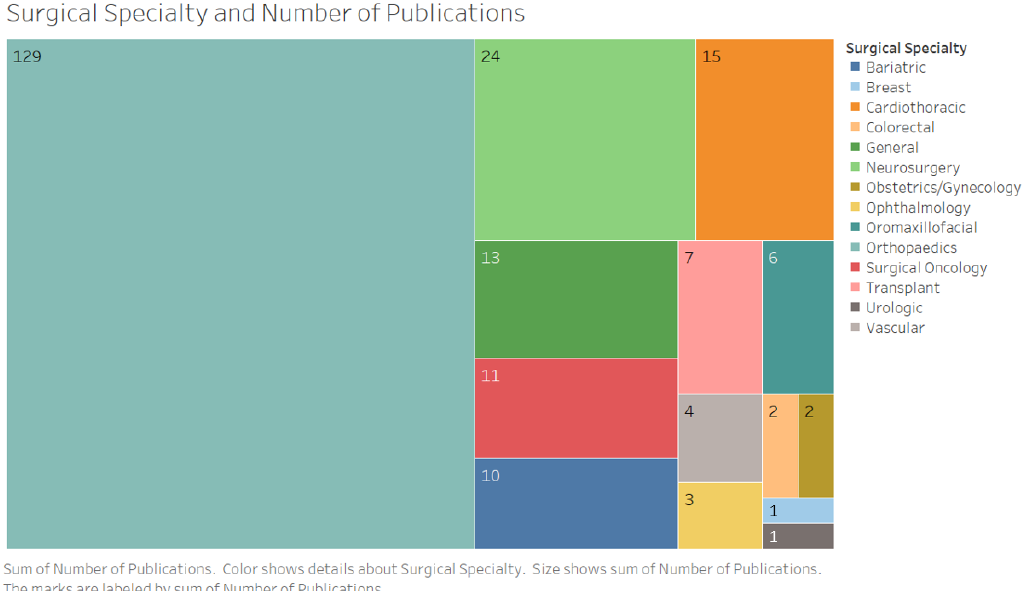
Figure 5. Area chart representing number of studies by surgical specialty. Studies spanned a total of 14 surgical specialties.